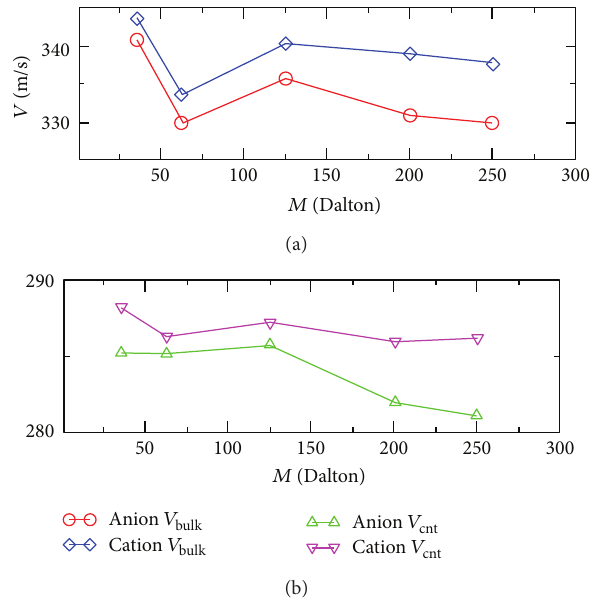
Figure 4: The flow velocities of the cation and anion depending on the different atomic masses of the anion, at a pressure of 𝑃 ≈ 2000 atm and at temperature of 𝑇 = 300 K. (a) Flow velocities of the cation and the anion in bulk solution. (b) Flow velocities of the cation and the anion in a (76,0) carbon